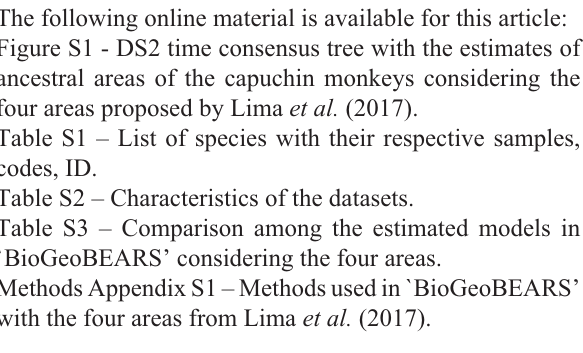
four areas proposed by Lima et al. (2017). Table S1 – List of species with their respective samples, codes, ID. Table S2 – Characteristics of the datasets. Table S3 – Comparison among the estimated models